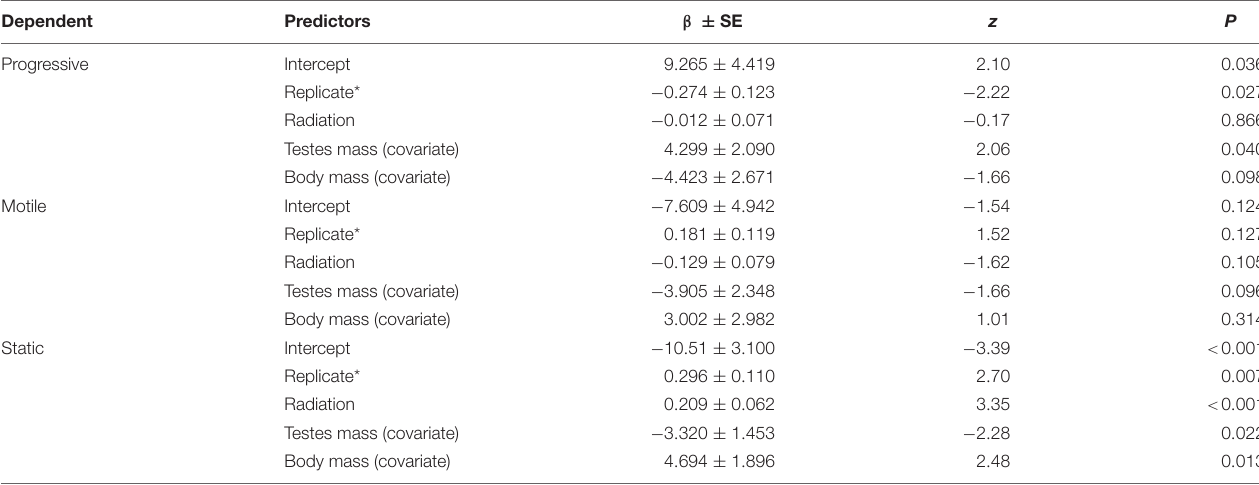
TABLE 2 | Test of radiation effects on sperm mobility (progressive, motile and static) in 14 bank voles. Replicate reflects an internal correlation between motility after 10 and after 60 min. All interactions between this variable and the predictors were tested and found to be non-significant. After correction for multiple testing, α is set at